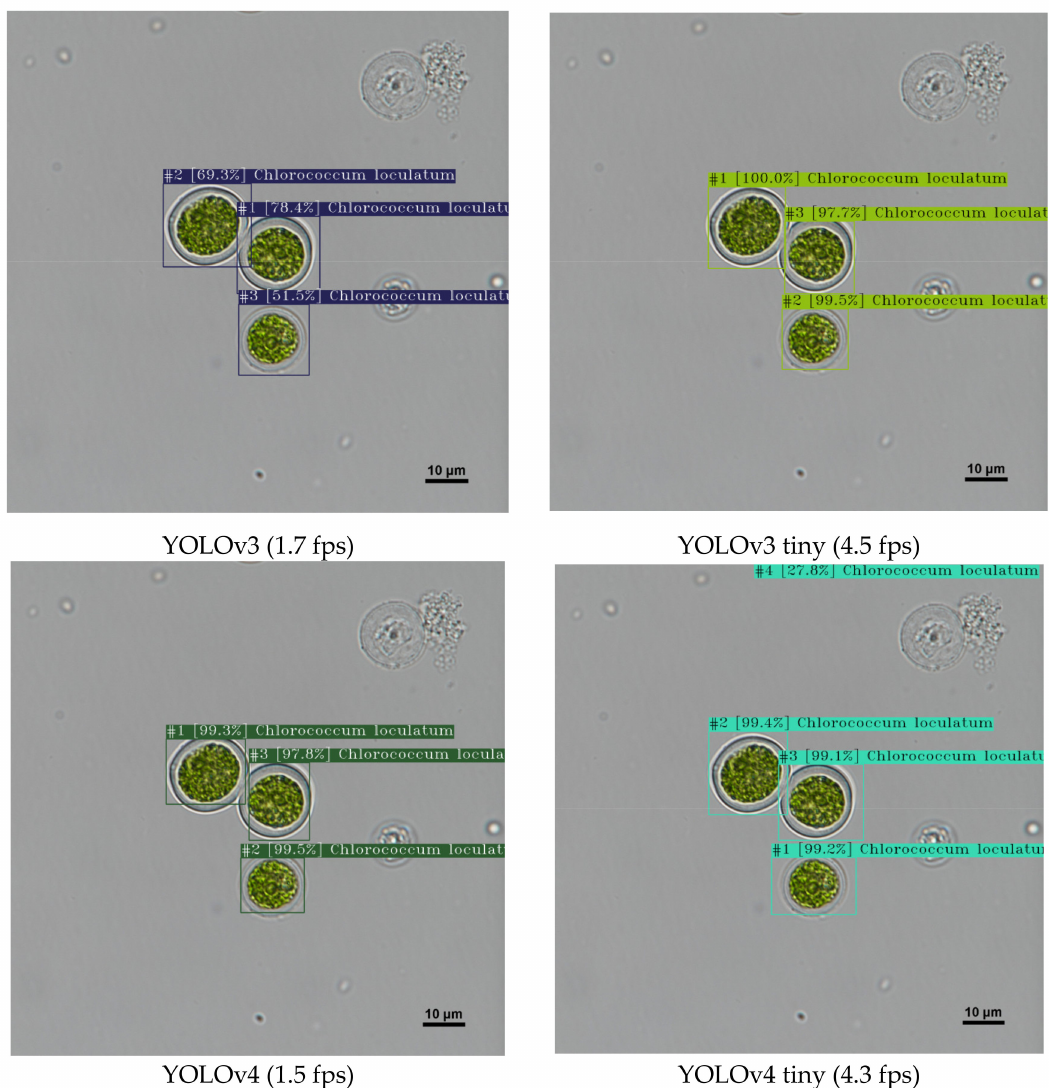
Figure 4. Comparison of the algal detection model performance with relatively large-size ( ≥ 10% of the image size)